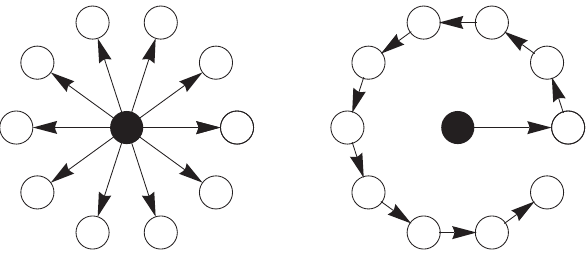
Figure 1. Two special spanning trees with minimum allometric exponent 1 (left, a star network) and maximum exponent 2 (right, a directed chain).